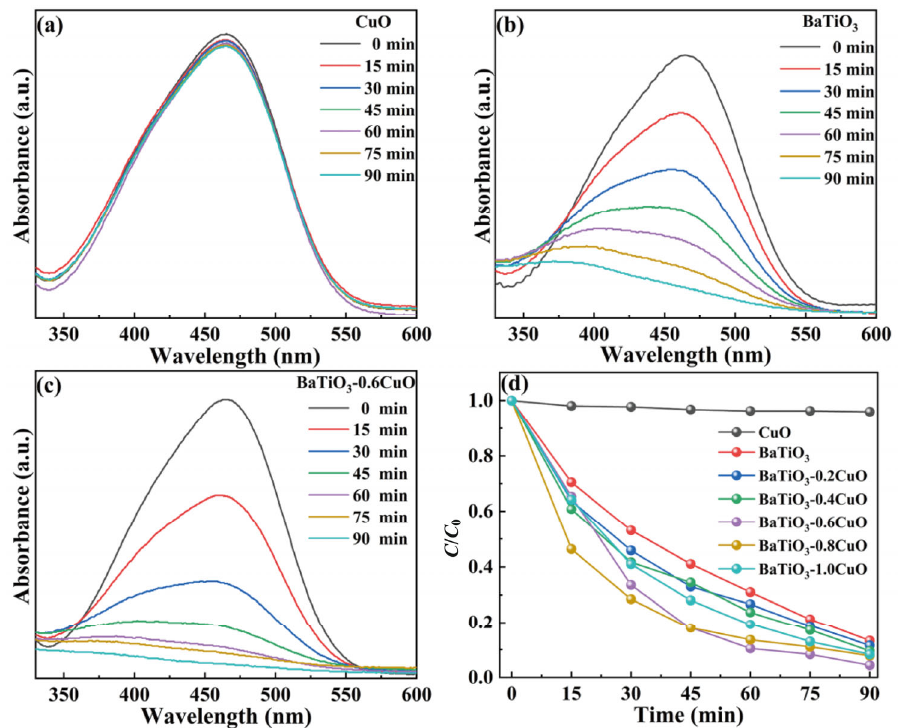
Fig. 6 UV–Vis absorption spectra of MO solutions undergoing different UV irradiation and vibration time for (a) CuO NPs, (b) BaTiO 3 NWs, and (c) BaTiO 3 –0.6CuO. (d) Comparison of piezo-photocatalytic activity of MO